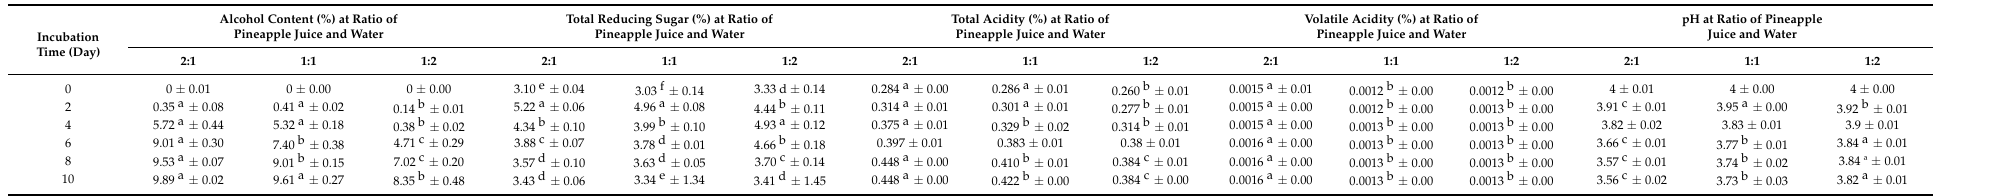
Table 2. Impact of the ratio of pineapple juice and water on the kinetic parameter of wine